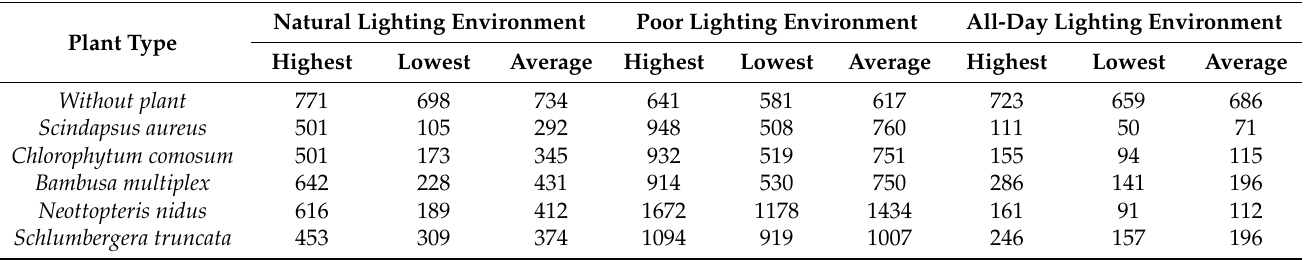
Table 5. Comparison of CO 2 concentration in six sealed chambers at three lighting